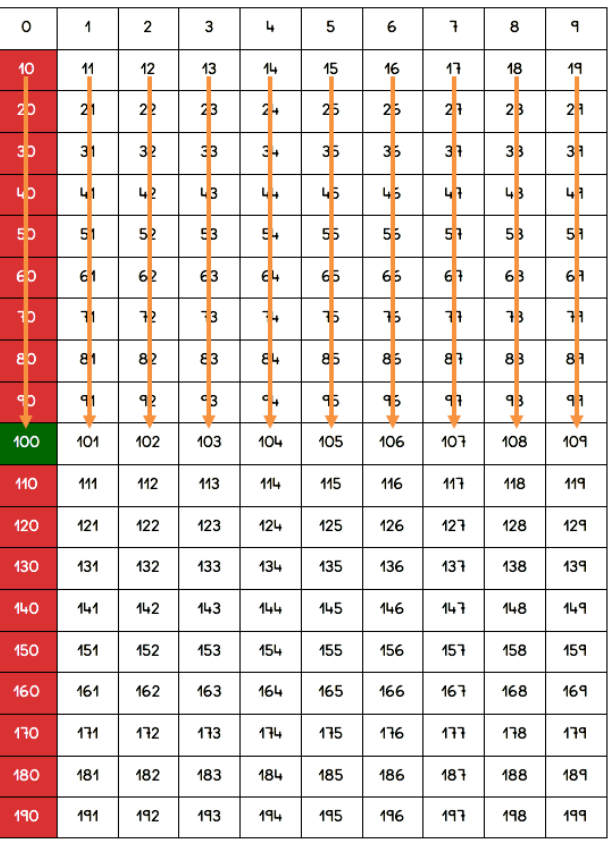
Figure 15. Getting the first line.